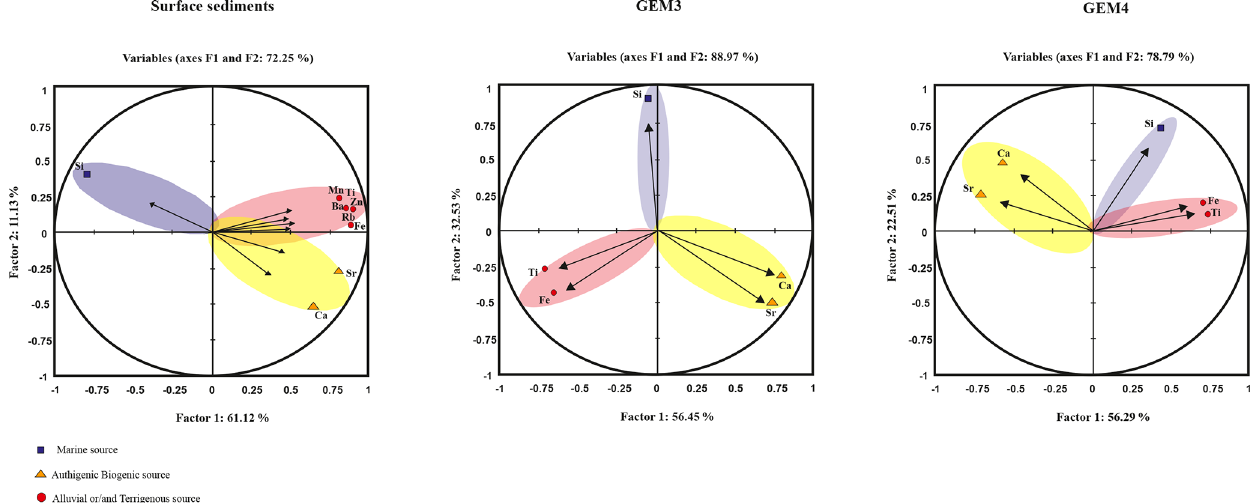
Figure 8. The different surface sediment sources from the Medjerda watershed and Ghar El Meleh lagoon obtained by using the statistic model as the principal component analysis